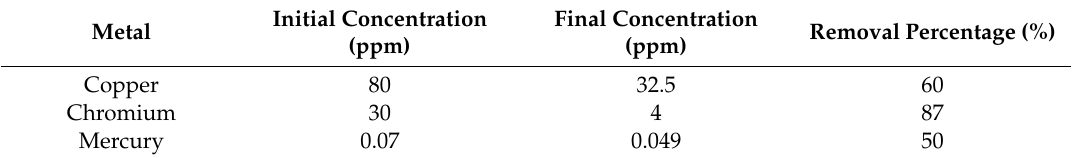
Table 1. Concentration before and after treatment of wastewater with MAT, as well as the removal percentage.